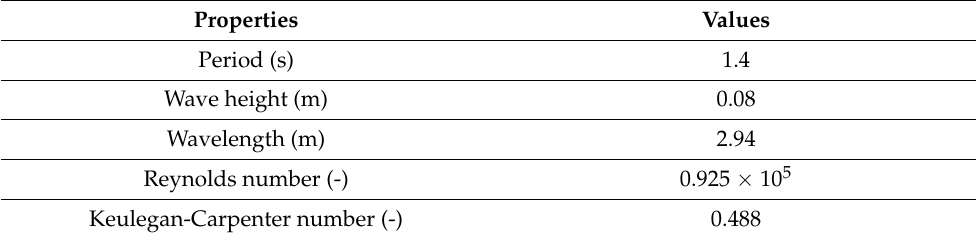
Table 3. Description of Stokes 5th order wave.